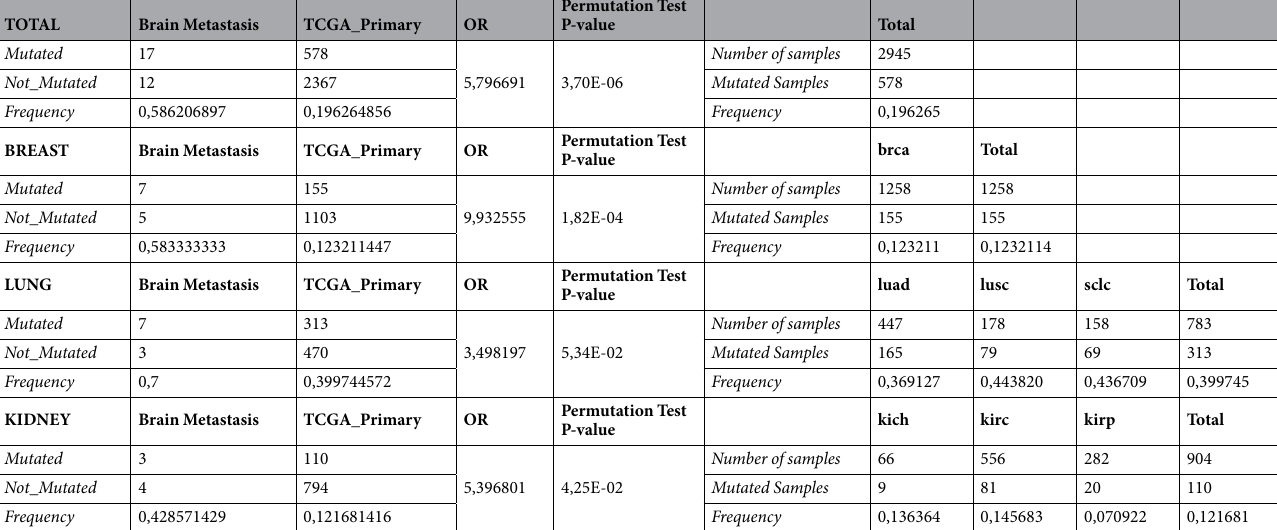
Table 1. Comparison of the frequency of mutations in the coagulation and complement pathway between primary tumours from TCGA-database and brain metastases of our cohort. We compare frequencies of mutations based on the origin of primary tumours (breast, lung and kidney). Mutational profile of these tumours, analysed according to the pathways, indicates that coagulation and complement cascade genes carry mutations at frequency significantly lower than brain metastases in each of the 3 different datasets (breast, lung and kidney cancer). OR: odds ratio brca: breast carcinoma; luad: lung adenocarcinoma; lusc: lung squamous cell carcinoma; sclc: small cell lung cancer; kich: kidney chromophobe; kirc: kidney renal clear cell carcinoma; kirp: kidney renal papillary